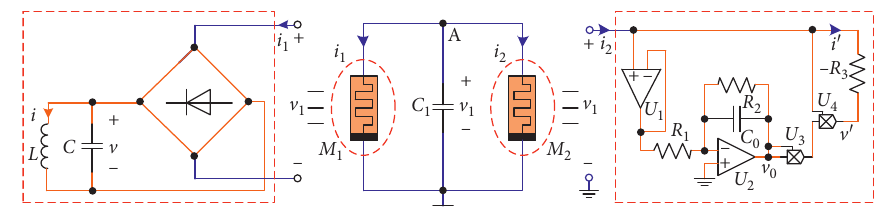
Figure 1: Circuit schematic of the proposed three-element-based memristive